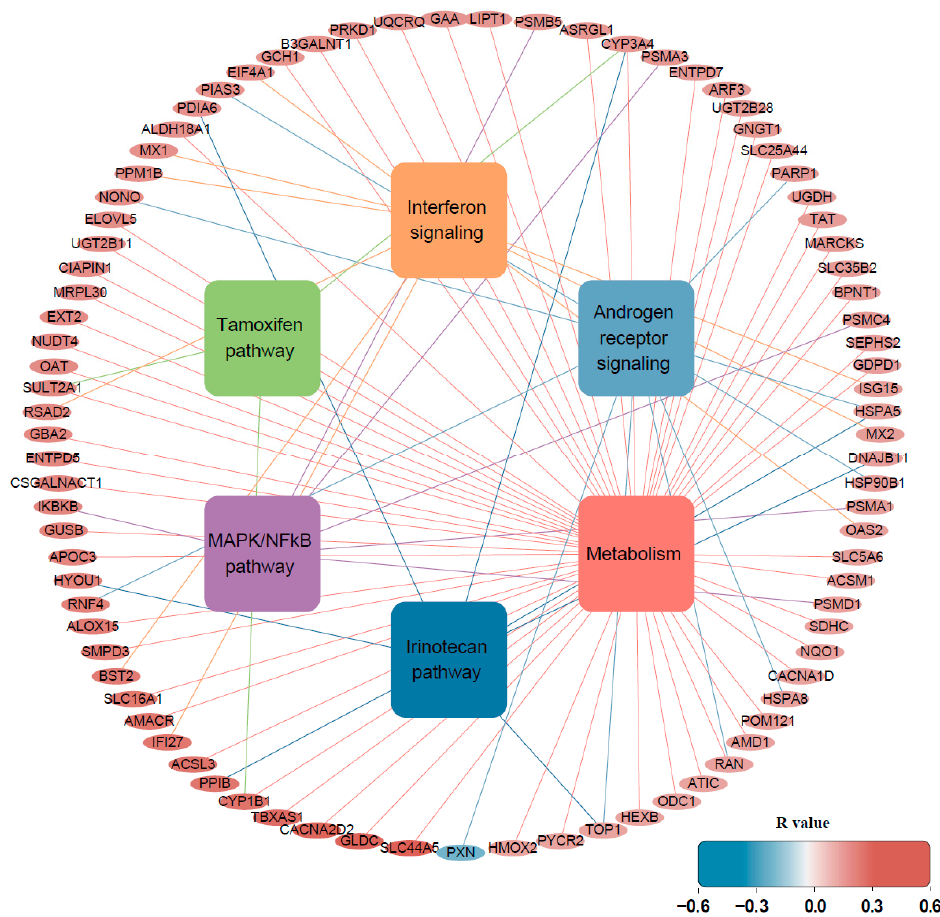
Figure 1. RNA expression heatmap of six cancer-specific pathways. RNA expression was converted into z-scores. Rows include each gene of the cancer-specific pathways arrayed by each pathway. Columns include each sample of an ETV4-fusion-positive or -negative group.